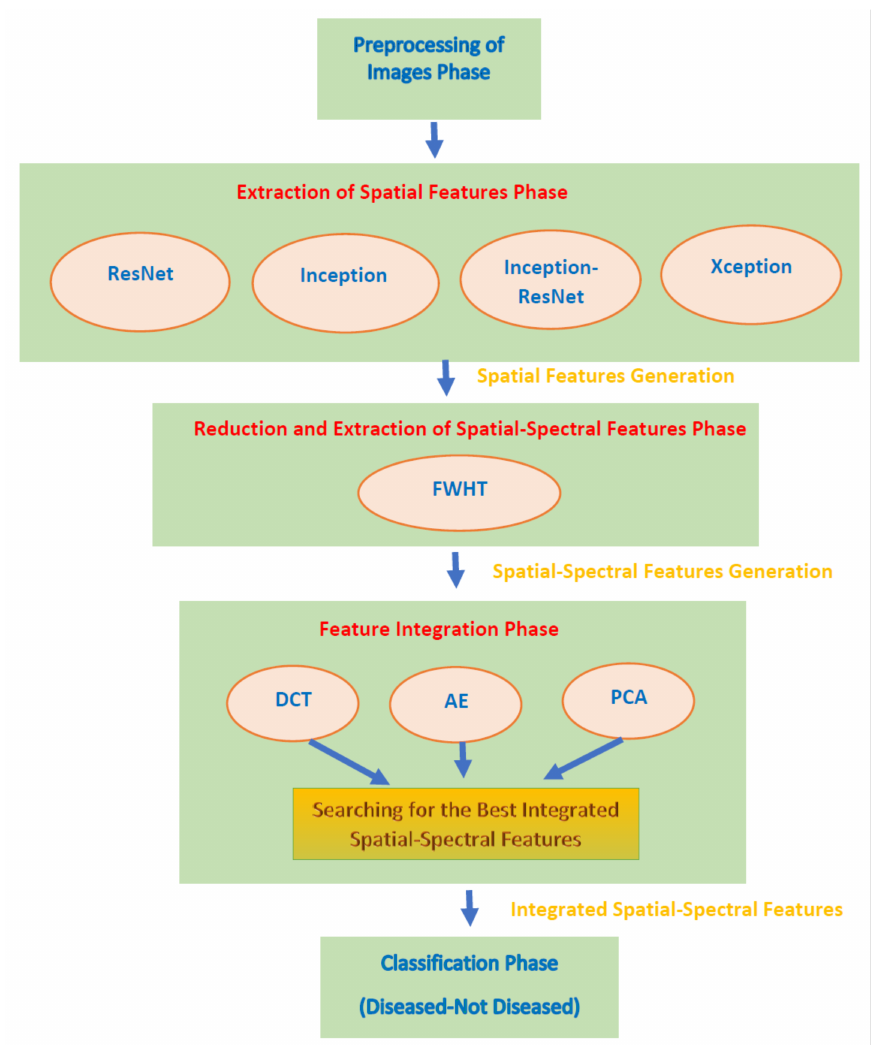
Figure 2. The five phases of the DIAROP diagnostic